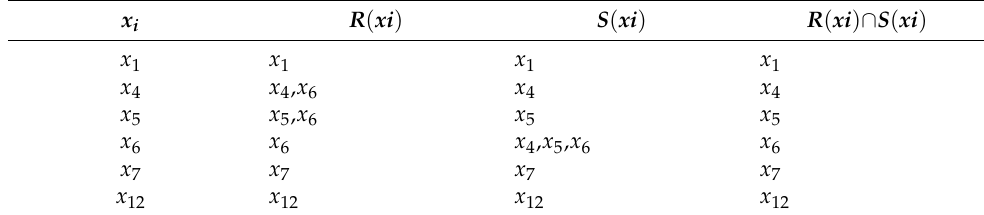
Table 8. Results of the second-level calculation.